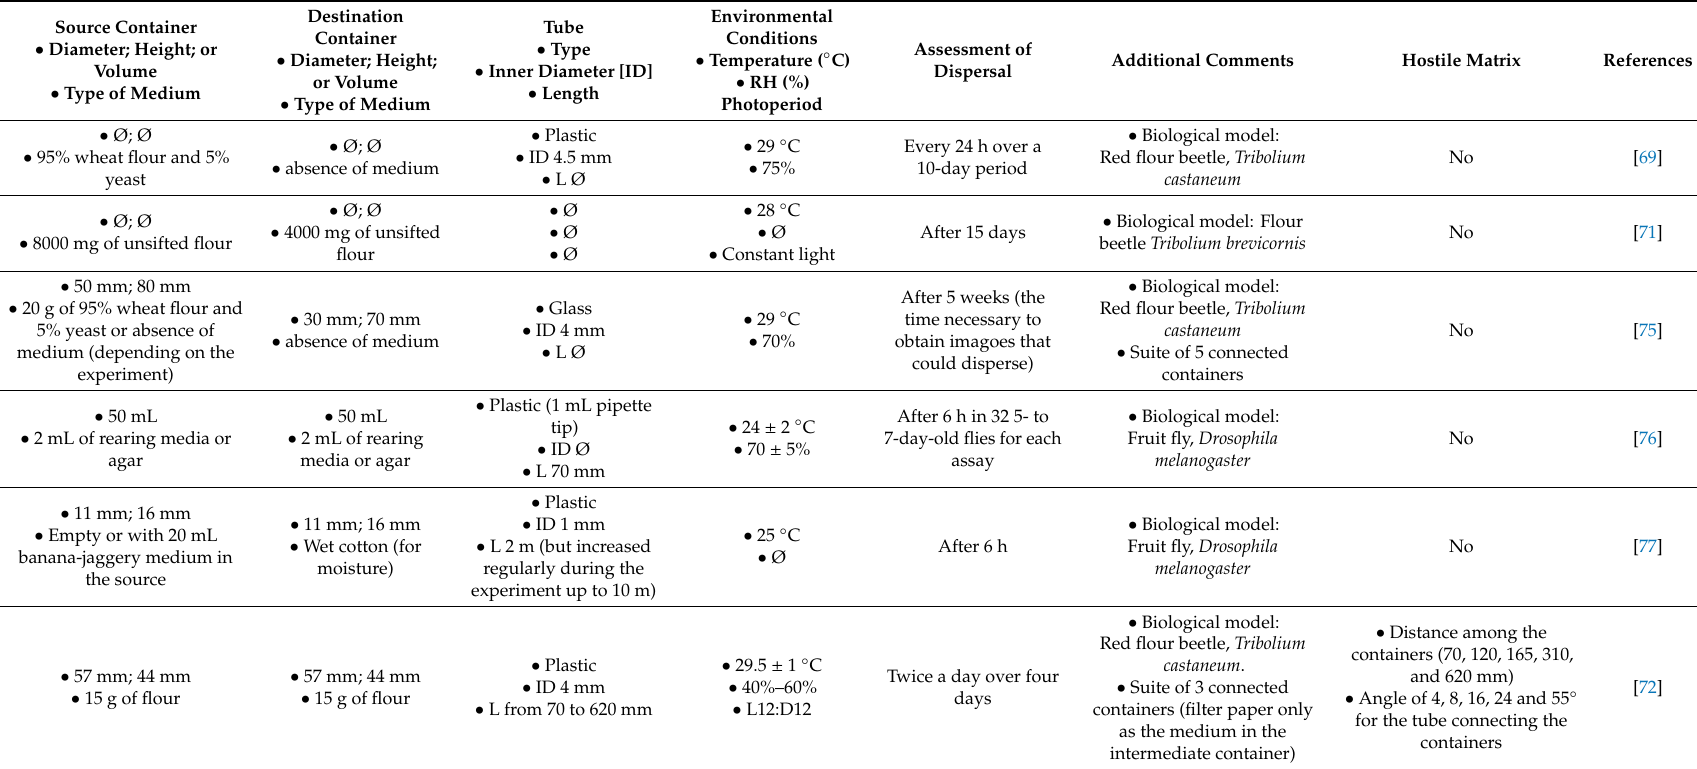
Table 1. Published examples of some experimental systems based on connected patches for studying insects’ dispersal under controlled conditions. The main characteristics of the source and destination containers (patches), the tube (dispersal corridor / pathway) connecting the two containers, and the environmental conditions are presented, in addition to the biological model and observation procedure used for the assessment of dispersal. The presence / absence of a hostile matrix is specified; when present, the main characteristics that made the matrix hostile is summarized. The last column mentions the source article. Ø: absence of information in the published